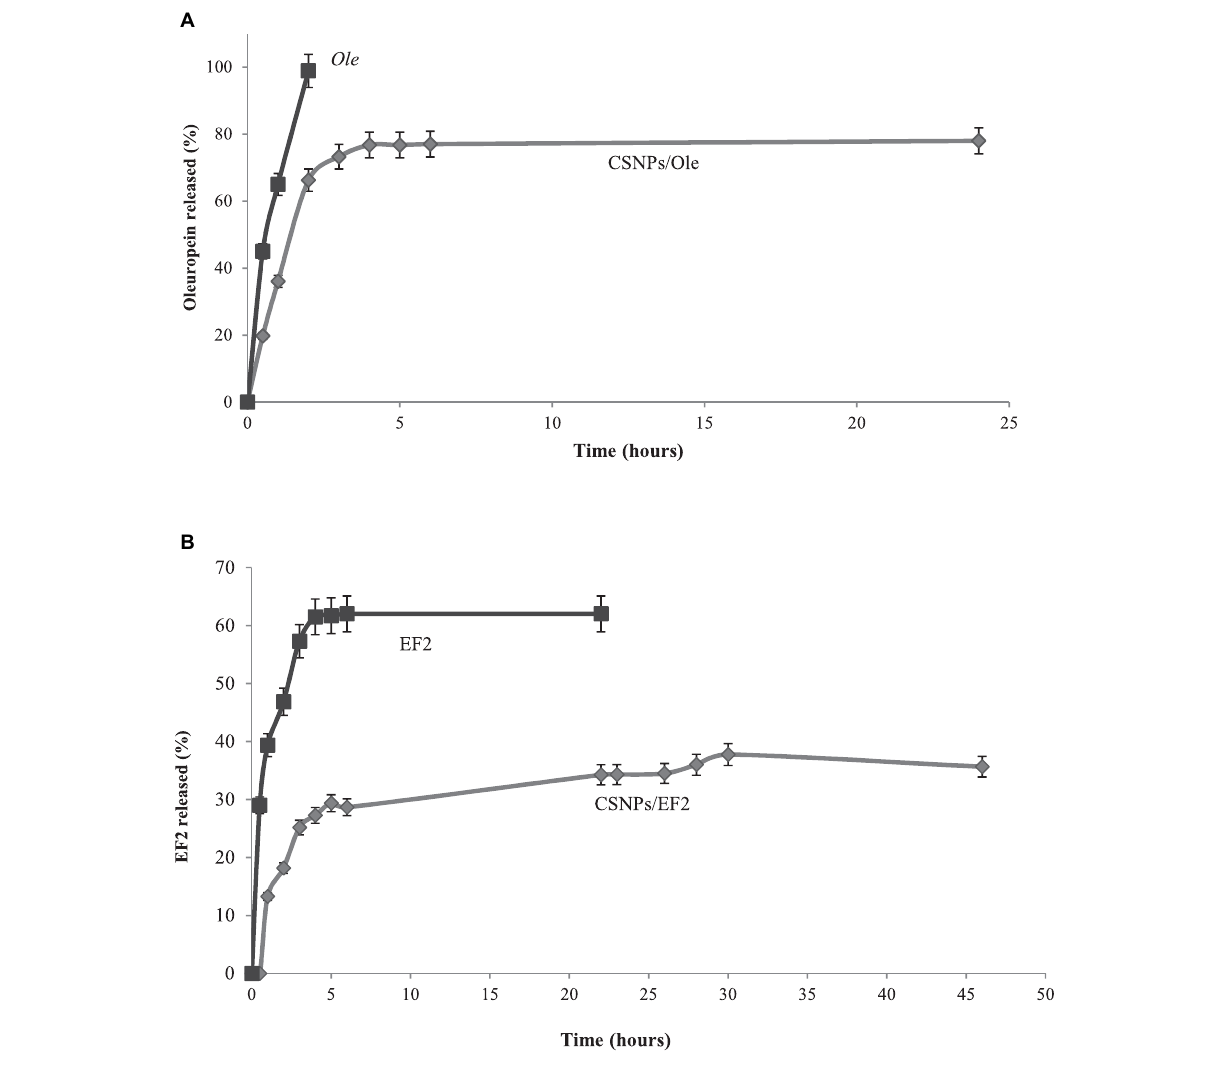
Frontiers in Bioengineering and Biotechnology |